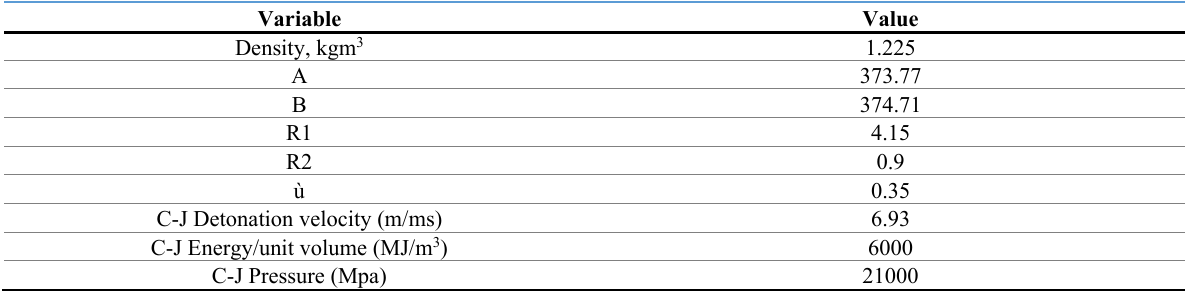
Table 4- Jones-Wilkins-Lee (JWL) constitutive parameters for TNT